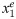
Reprogramming efficiency against overexpression condition.Plotted here are Reprogramming efficiency against the product of overexpression value x1e for the gene x
1 and its duration time T
e semi-log plot. We counted the number of reprogrammed cells (that are differentiated after oscillation). The average reprogramming ratio represents the percentage of reprogrammed cells per simulation. There was a peak around the product x1eTe∼103.1. If the product x1eTe was small (x1eTe<103), cells quickly returned to the differentiated fixed-point. Inversely, if it was large (x1eTe>103.3), cells fell into the pluripotent fixed-point, and did not show differentiation.